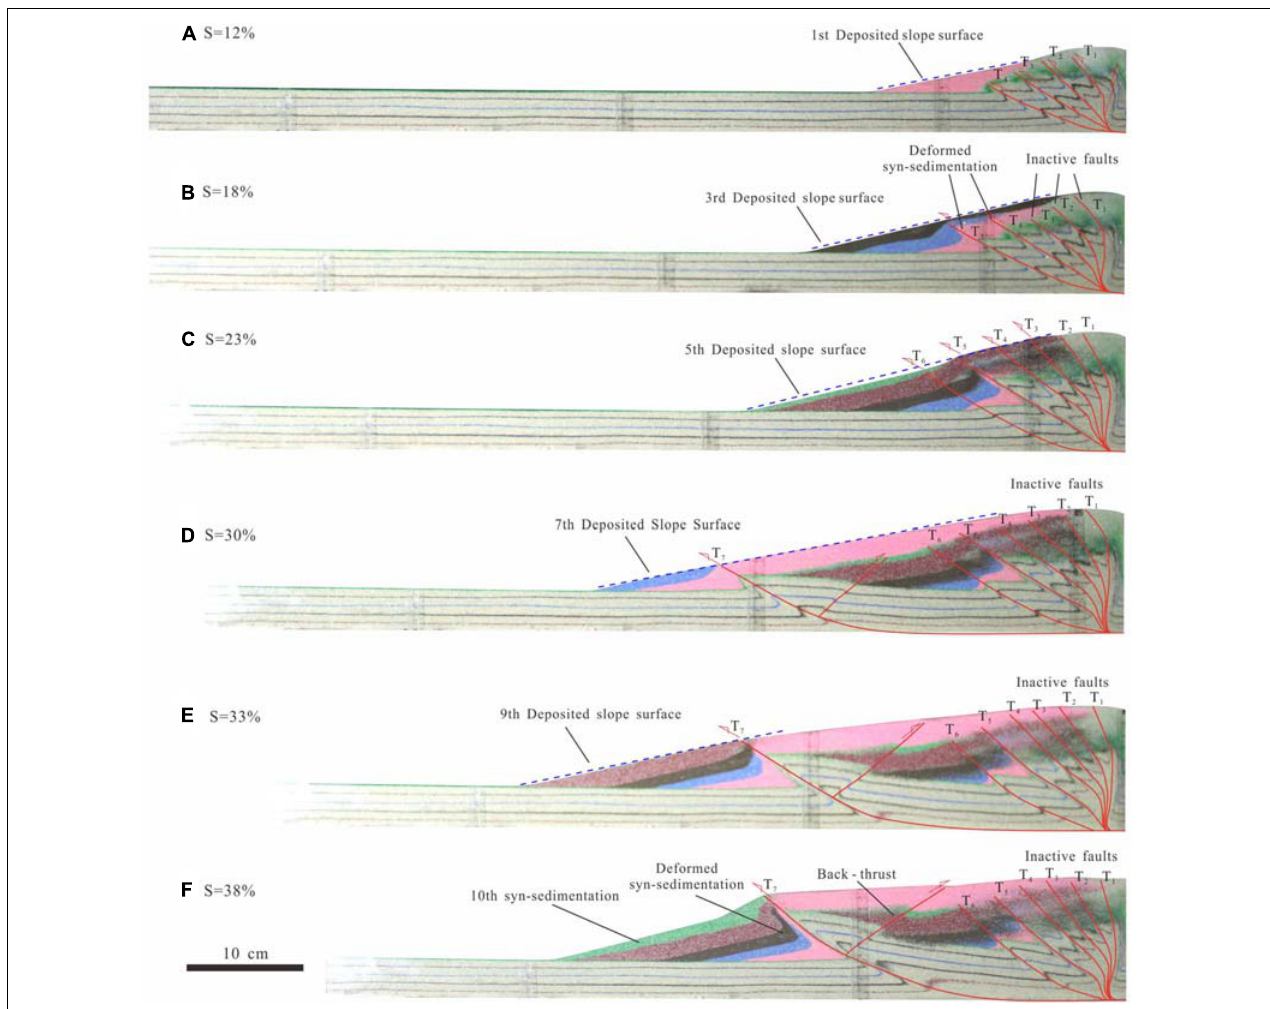
FIGURE 6 | Experiment results of Saturated (high-rate) sedimentation model (S3). (A–F) Sequential photographs showing the structural evolution of wedge. TABLE 3 | Summary results of sedimentation and formation of thrusts with shortening. Group